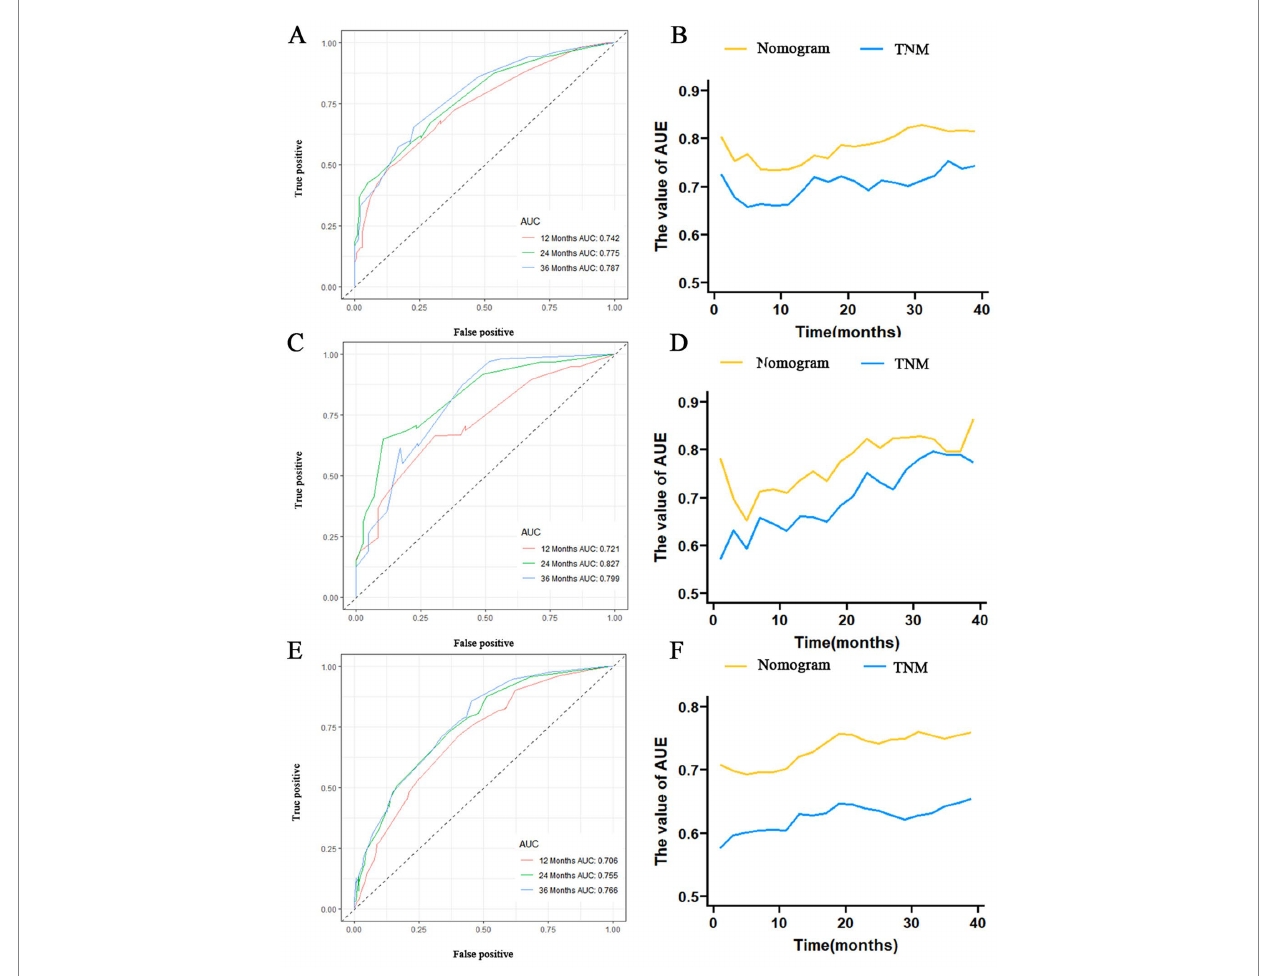
FIGURE 9 Receiver operating characteristic (ROC) curve analysis of nomograms at 12-, 24-, and 36-months in the training set (A) , validation set (C) and extended validation set (E) . Time-dependent ROC curves for comparing the discriminatory ability between nomograms and TNM staging system in the training set (B) , validation set (D) and extended validation set (F)